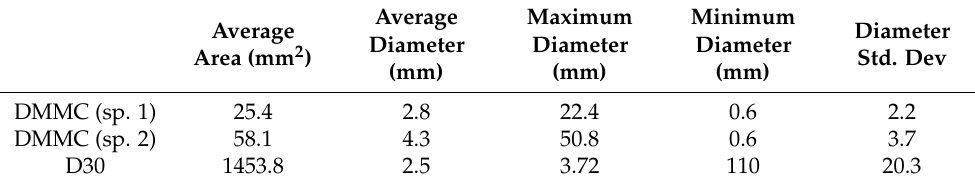
Figure 3. Microscopical section view of diamond distribution in DMMC ( left ) and D30 ( right ) coatings. Table 2. Diamond particles dimension distribution on coated